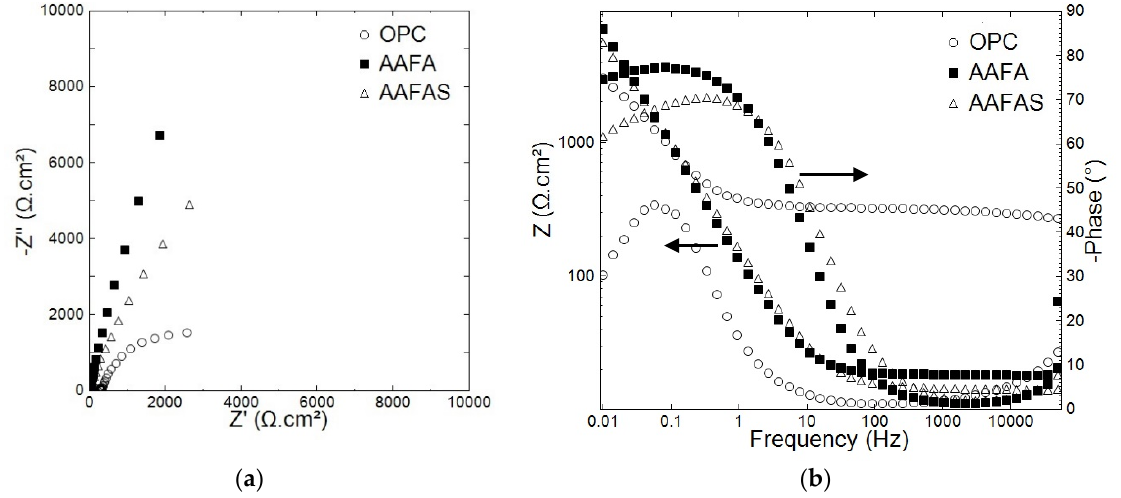
Figure 8. Nyquist ( a ) and Bode ( b ) diagrams of carbon steel embedded in OPC, AAFA, and AAFAS mortars exposed to carbonation for 21 days (1% CO 2 , 66% rH).